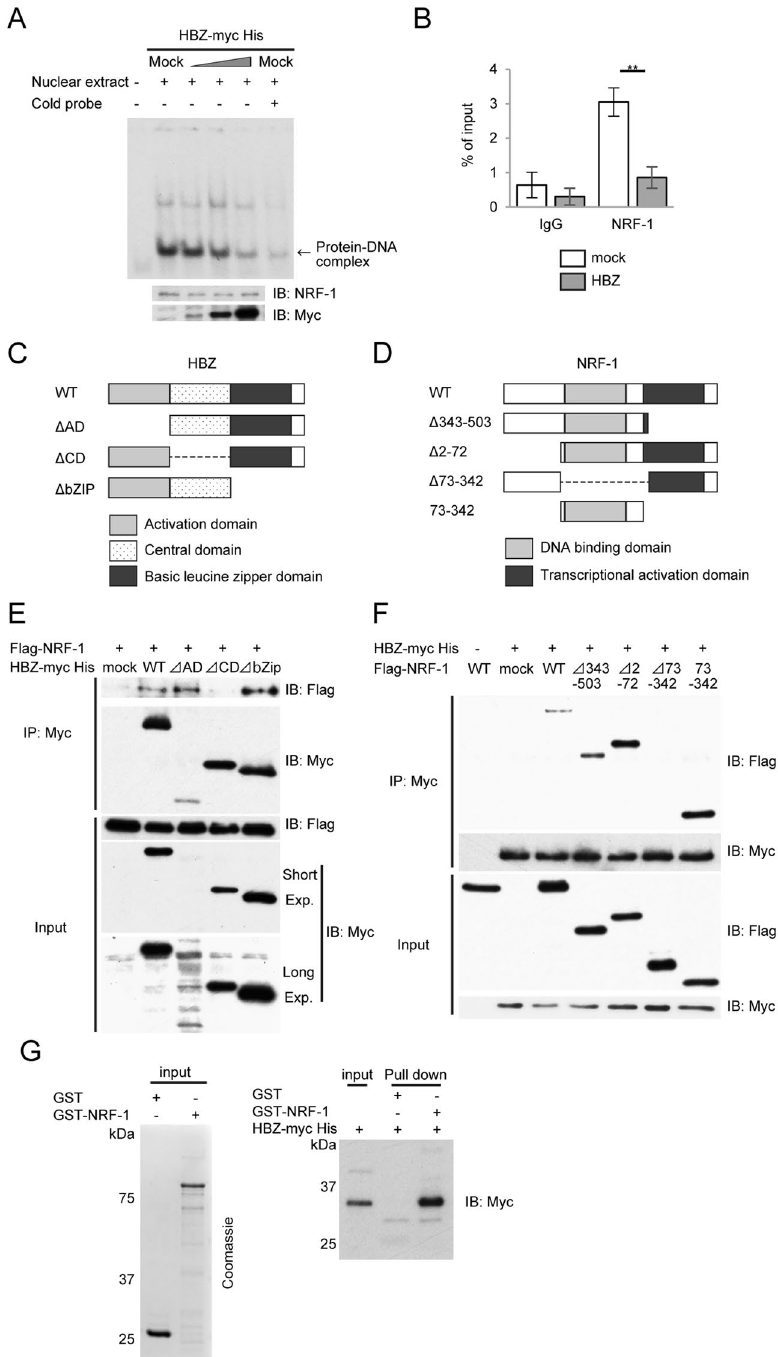
Figure 5. HBZ inhibits the DNA-binding activity of NRF-1 by physical interaction with NRF-1. ( A ) HBZ reduces NRF-1 binding to the NRF-1-binding motif in the TDP1 promoter. A gel-shift assay was used to analyze protein-DNA interactions. HEK293T cells were transfected with increasing amounts of HBZ (0, 1, 2, and 4 µ g). Expression of NRF-1 and HBZ protein contained in the nuclear extracts was analyzed by immunoblotting. The position of the relevant protein-DNA complexes is indicated by the arrow. ( B ) Jurkat T cells and Jurkat- HBZ cells were immunoprecipitated with anti-NRF-1 antibody and quantified by real-time PCR. Data shown are the mean ± SD (n = 3). ( C ) Schema of HBZ gene. ( D ) Schema of NRF-1 gene. ( E ) and ( F ) The expression vectors of the indicated proteins were co-transfected into HEK293T cells, and their interactions were analyzed by co-immunoprecipitation assay. ( G ) NRF-1 was purified from E. coli as a GST fusion protein. GST alone or GST-NRF-1 was incubated with in vitro transcribed/translated HBZ-mycHis. GST pull-downs and input were subjected to Western blotting with anti-Myc